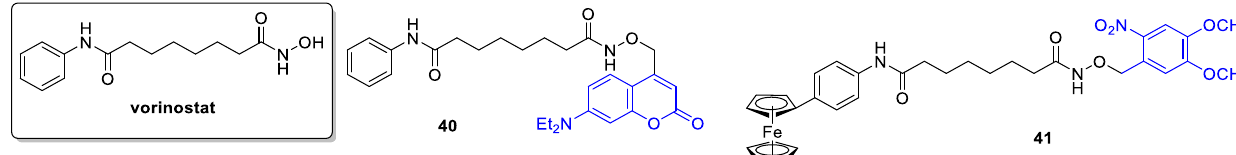
Figure 9. Photoactivatable HDAC inhibitors, the PPG indicated in